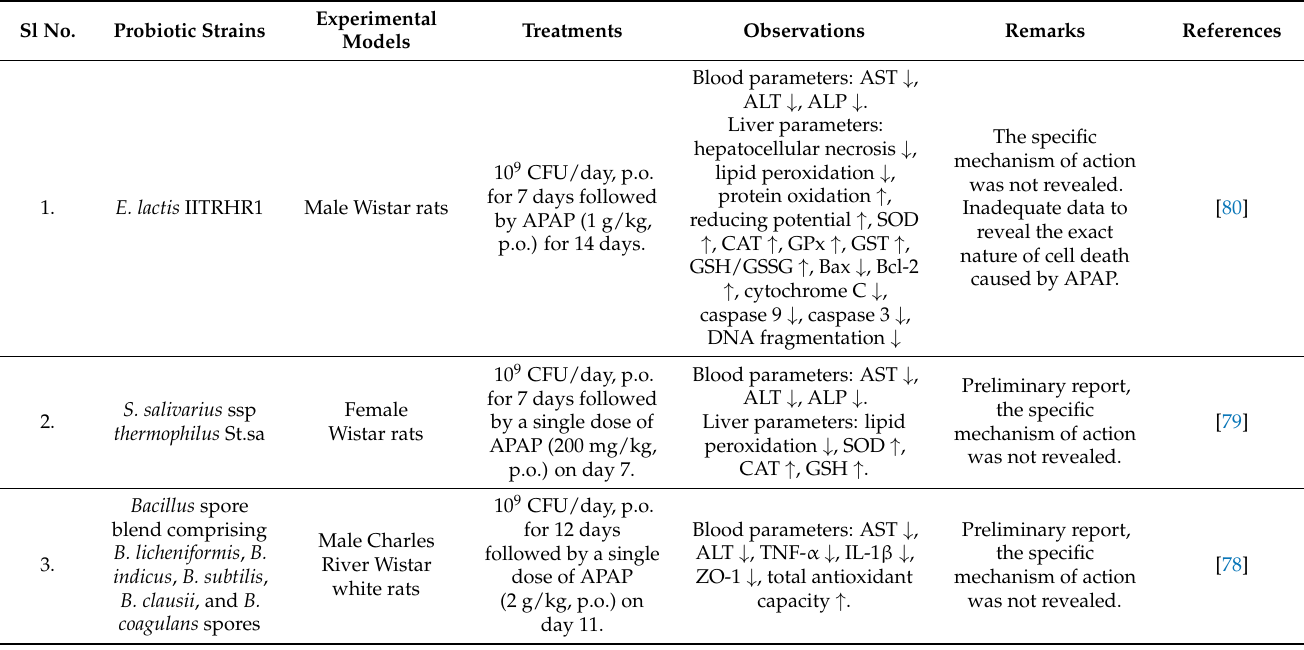
Table 2. A summary table representing hepatoprotective roles of probiotics against APAP hepatotoxicity. Sl